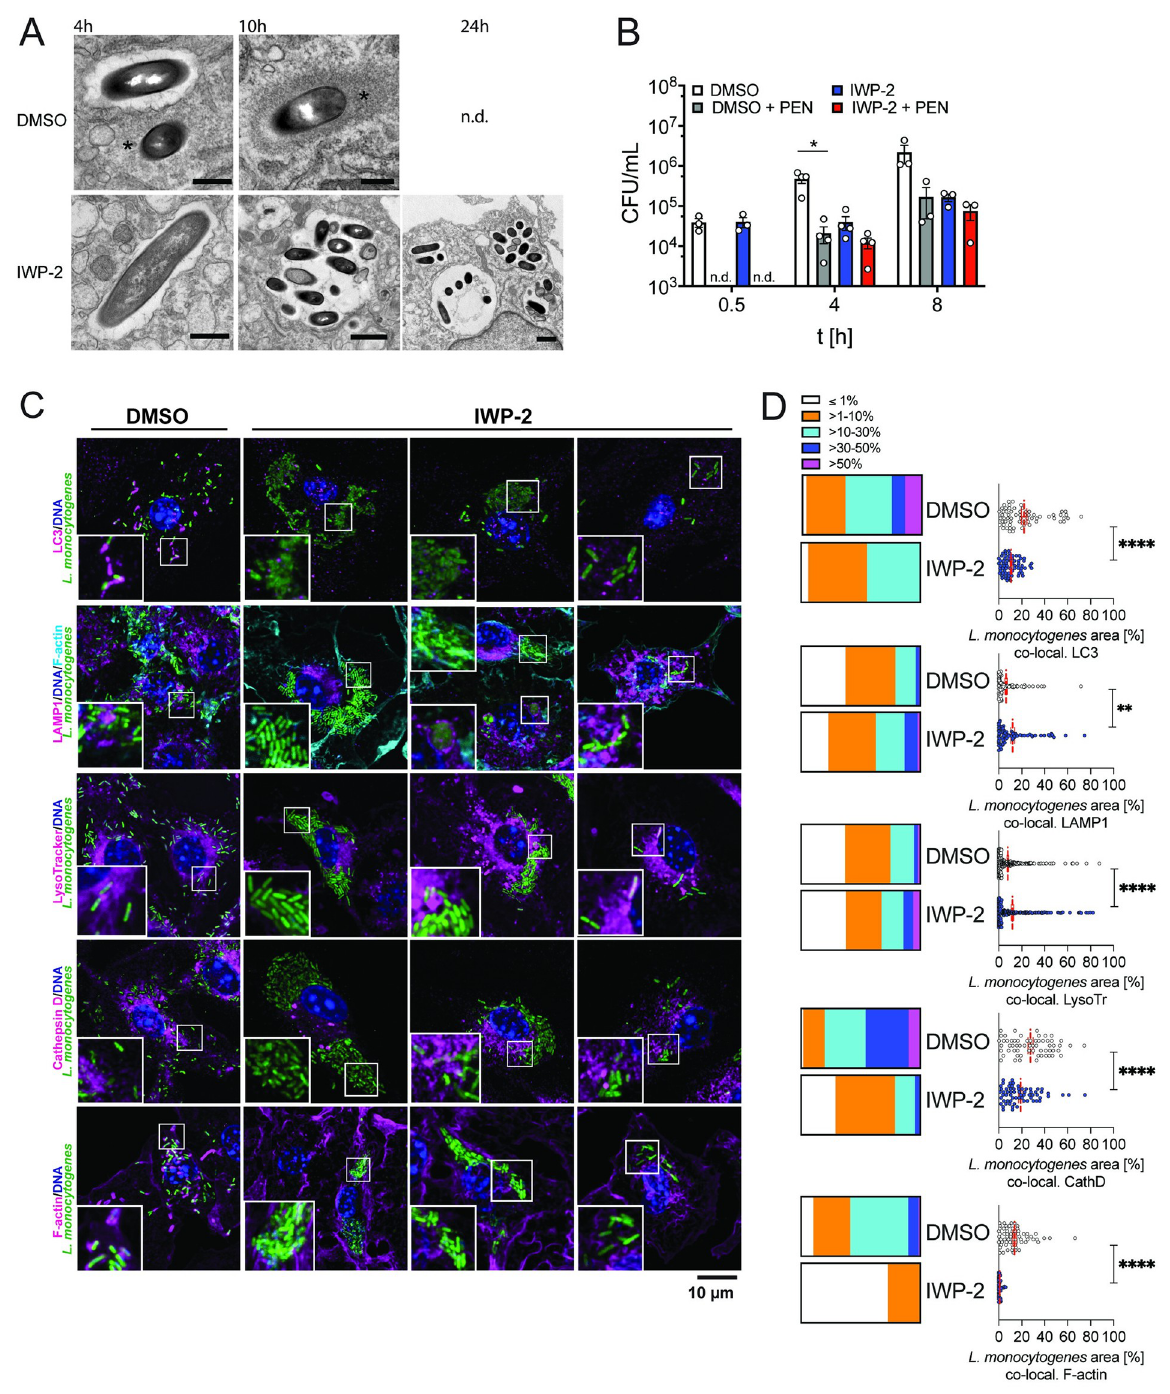
Fig 5. PrfA inhibition enables extensive intra-macrophage replication of L . monocytogenes inside spacious vacuoles. (A) L . monocytogenes in IWP-2-treated mouse bone marrow-derived macrophages (BMM) reside and replicate inside spacious single-membrane vacuoles as revealed by transmission electron microscopy (TEM) (scale bars 0.5 μ m DMSO 4 h, 10 h, IWP-2 4 h; 1 μ m IWP-2 10 h, 24 h; asterisks indicate polymerized actin associated with cytoplasmic bacteria). Similar observations were made in two independent experiments (n.d., not determined). (B) L . monocytogenes replicating inside spacious vacuoles are protected from penicillin. BMM were infected with L . monocytogenes in the presence of IWP-2 (10 μ M) or DMSO as control. Protection from penicillin (60 μ g/ml) addition to infected cells was determined by assessing intracellular bacterial burden at the indicated time points. Data are means +/- sem of 3–4 independent experiments, each performed in triplicates. Two-way ANOVA with Tukey correction for multiple comparisons; � P < 0.05. (C,D) Spacious vacuoles that support extensive L . monocytogenes replication